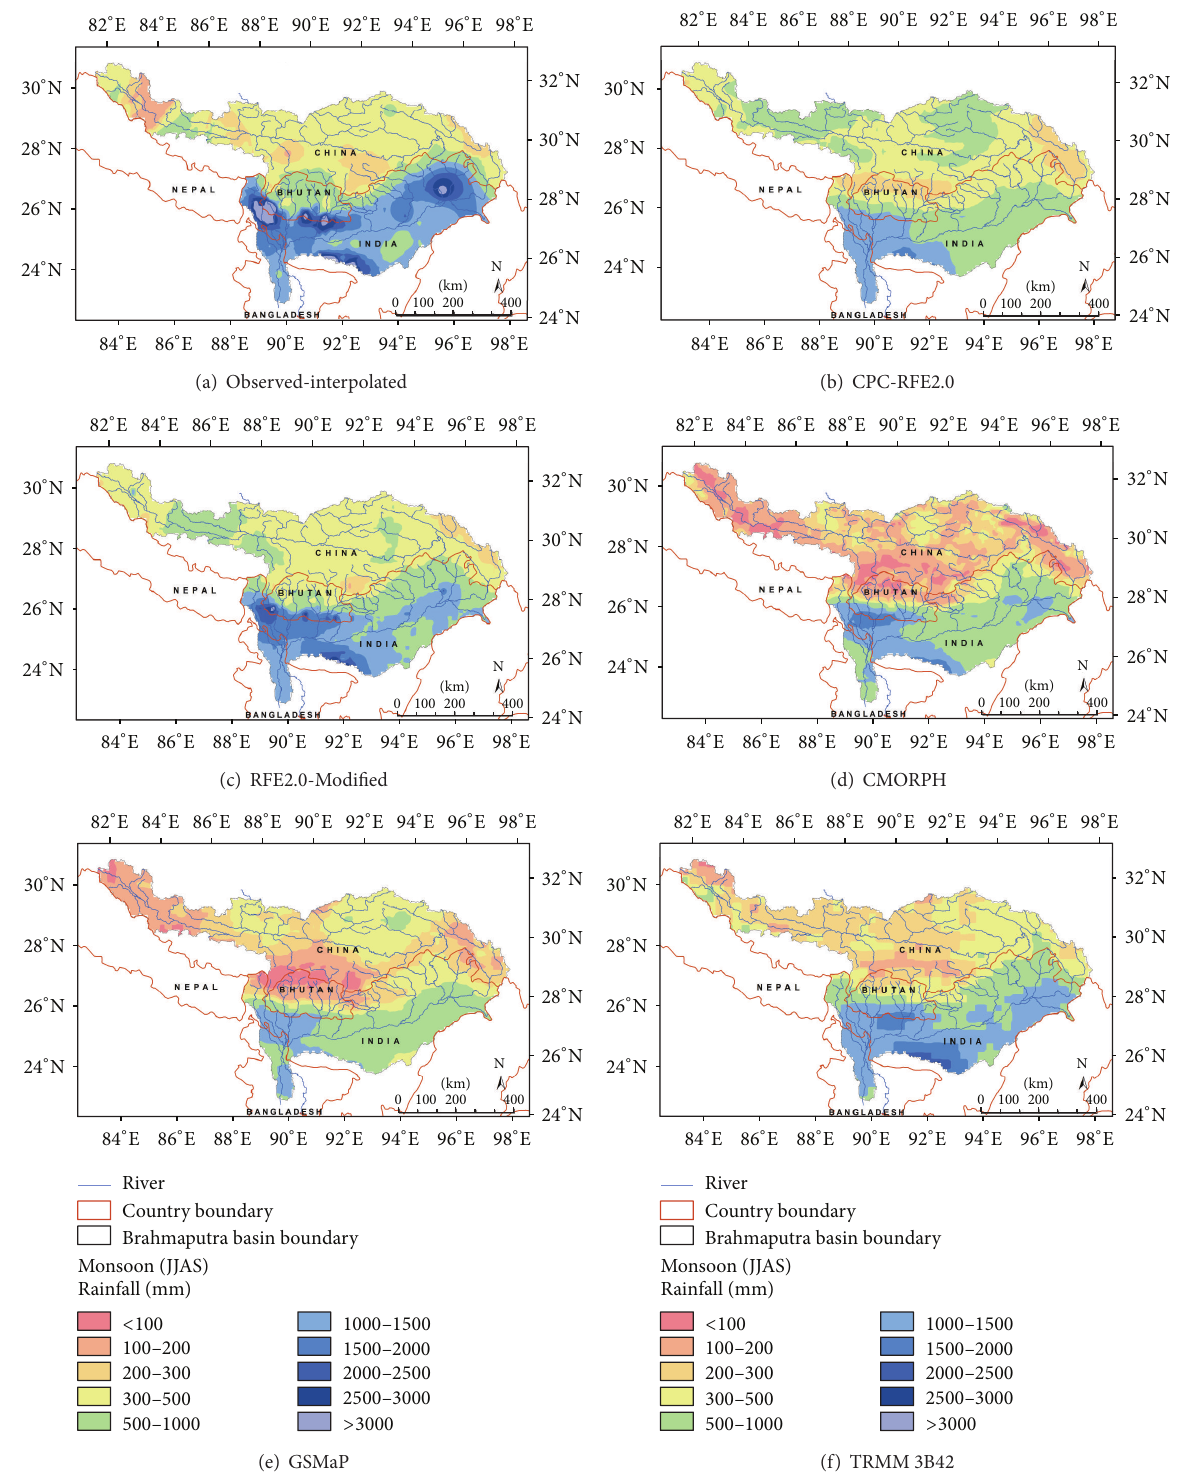
Figure 8: Average monsoon rainfall distribution in the Brahmaputra basin in 2004 to